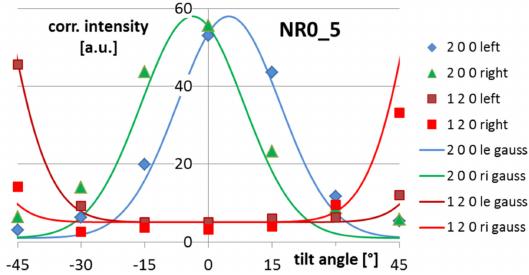
Figure 6. Measured intensities of the crystallite peaks (symbols) and model of the intensities using a Gaussian distribution superimposed to certain randomly distributed crystallites for the orientation distribution of crystallites in the unfilled stretched natural rubber with a stretch ratio 5:1, NR0_5, parameters in Table 1 (continuous